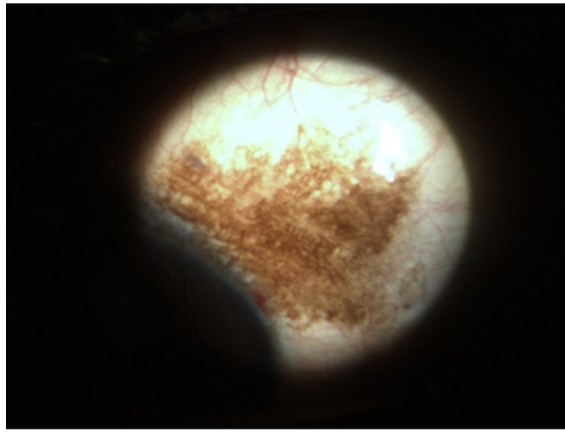
Figure 2: Clinical appearance of the temporal lesion at bulbar conjunctiva (LE)